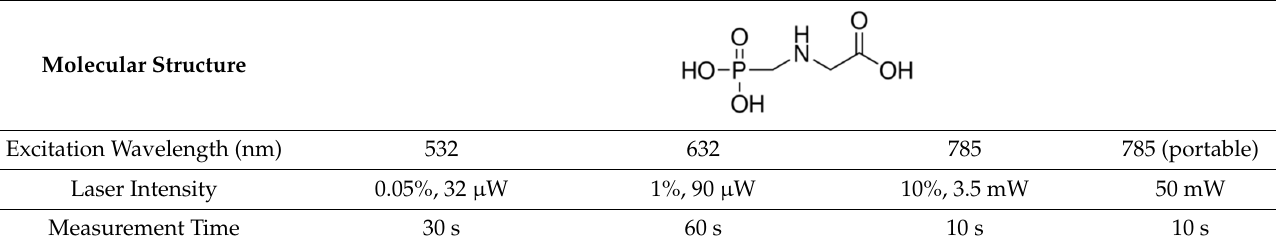
Table 1. SERS measurement parameters for glyphosate.